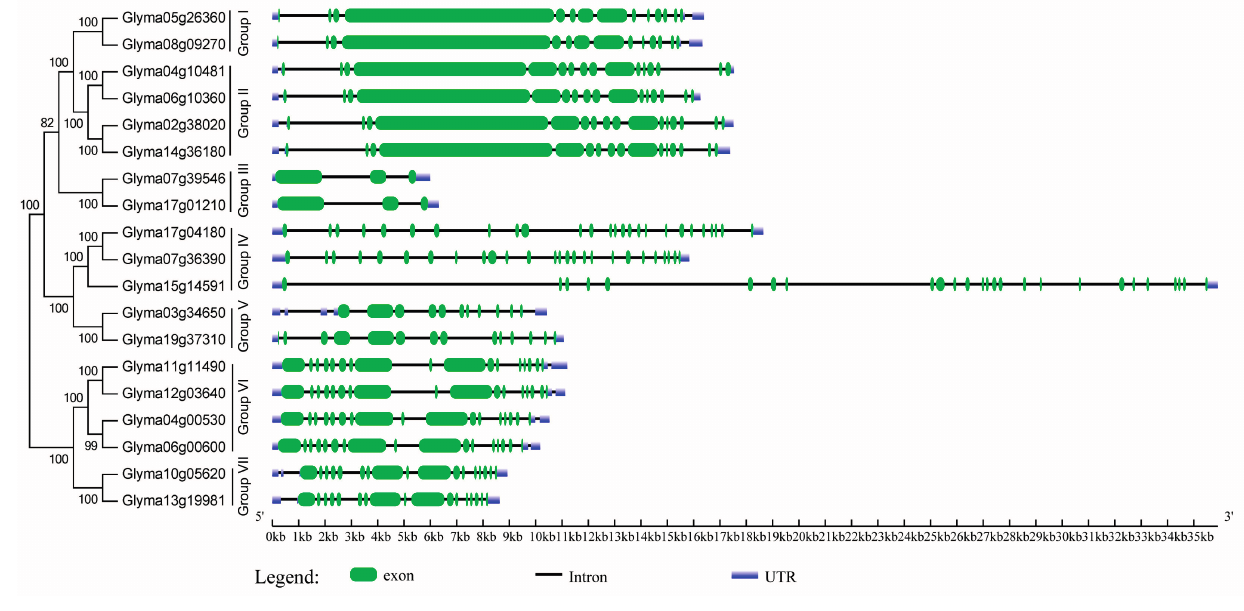
Figure 3. Phylogenetic relationships and exon/intron structures of HECT proteins in soybean. The unrooted neighbor-joining tree was constructed via the alignment of full-length amino acid sequences (File S3), using the MEGA6 package. Lengths of the exons and introns of each HECT gene are displayed proportionally. The green boxes, blue boxes, and lines indicate exons, untranslated regions (UTRs), and introns, respectively.